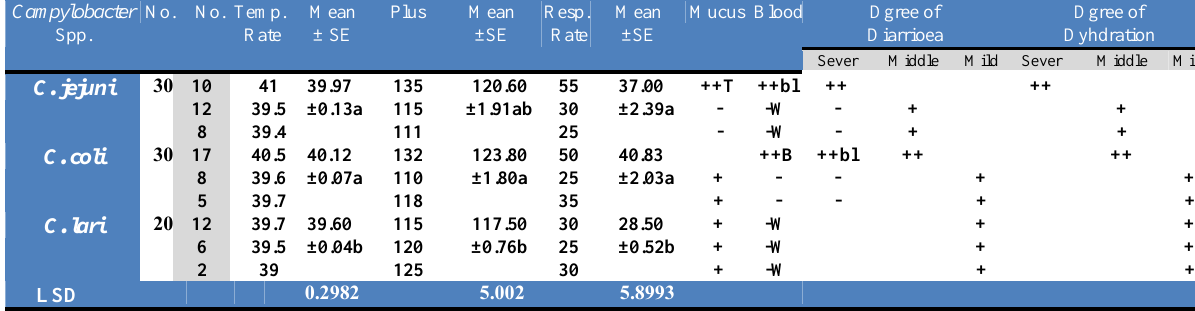
Table, 8: Clinical signs of cows infected with Campylobacter